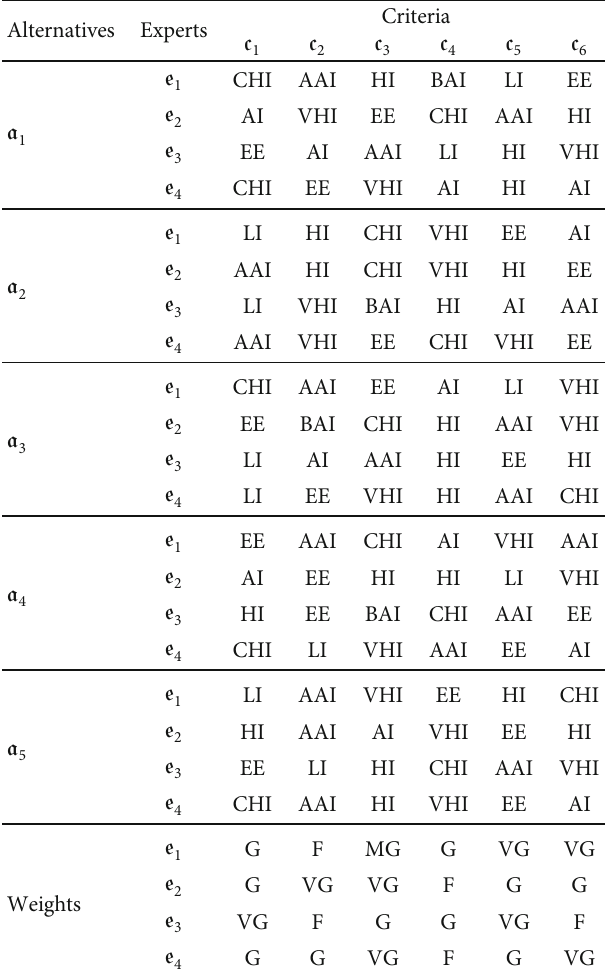
Table 4: Judgments/assessments given by four experts in terms of LTs.